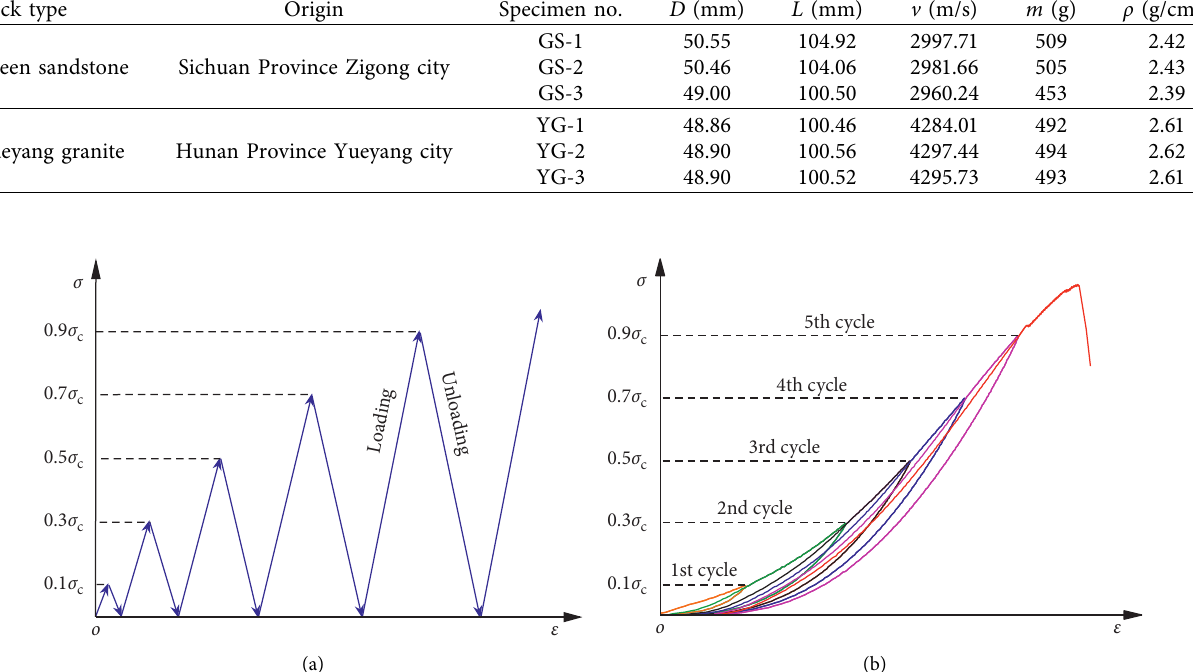
Figure 2: Schematic diagram of rock specimen in cyclic loading-unloading test. (a) Stress loading path (b) Stress-strain curve mode.